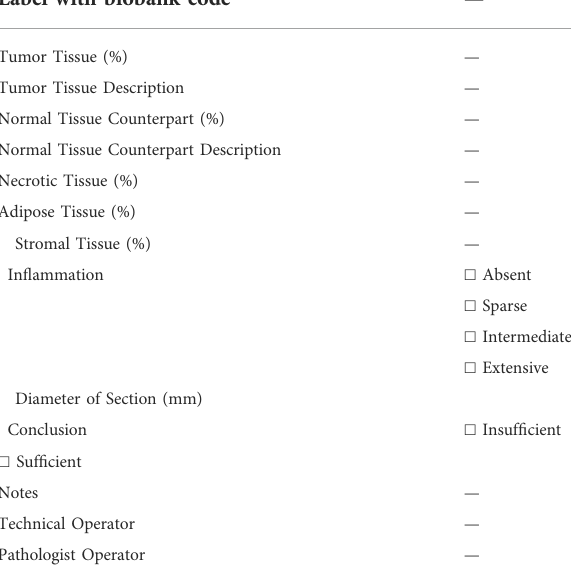
TABLE 3 Representative quality Control Form of tissue sections included in OCT and